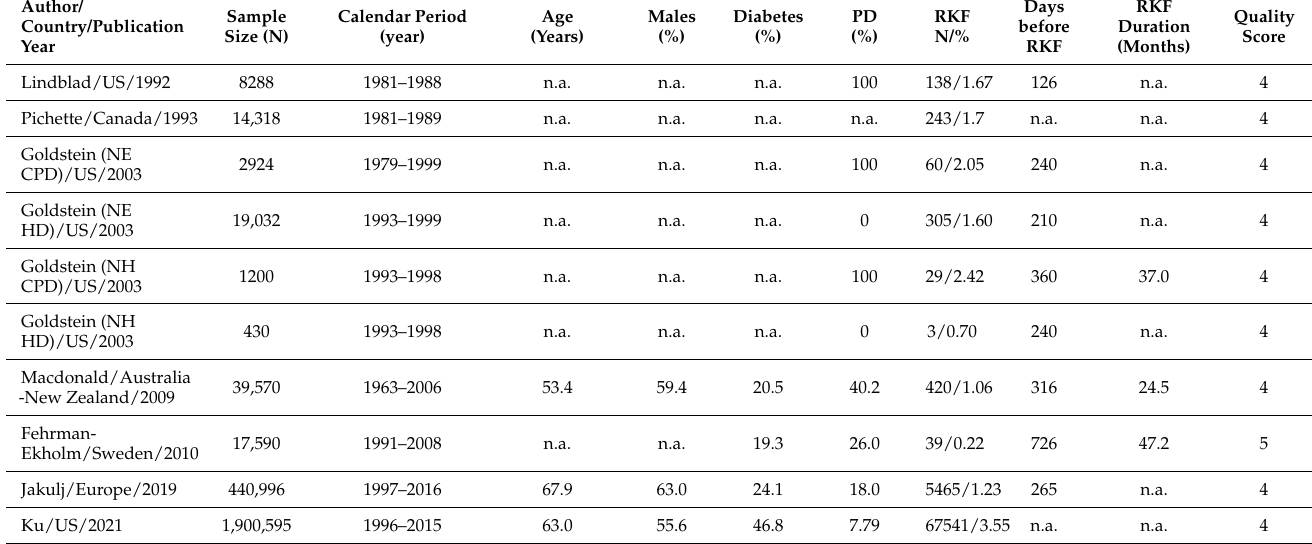
Table 1. The Newcastle–Ottawa Scale (NOS) was used for quality